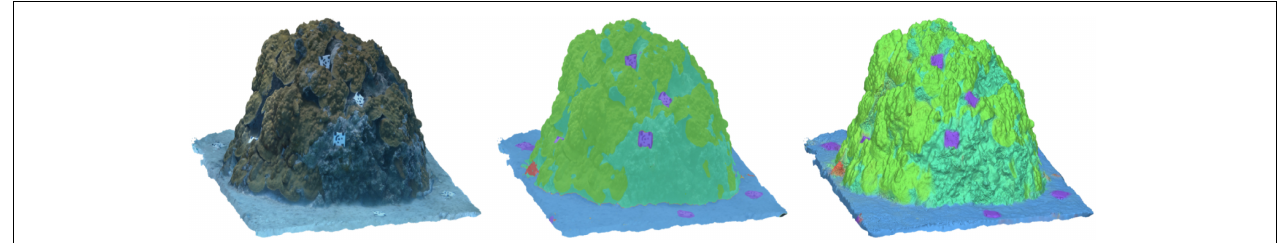
FIGURE 8 | A side-by-side comparison between the textured mesh (left), the classified textured mesh with 40% transparency (center), and the classified shaded mesh (right). The classified textured mesh was used as a method for validating the classification results of the classified shaded mesh and dense point cloud (not shown), which can be used in spatial